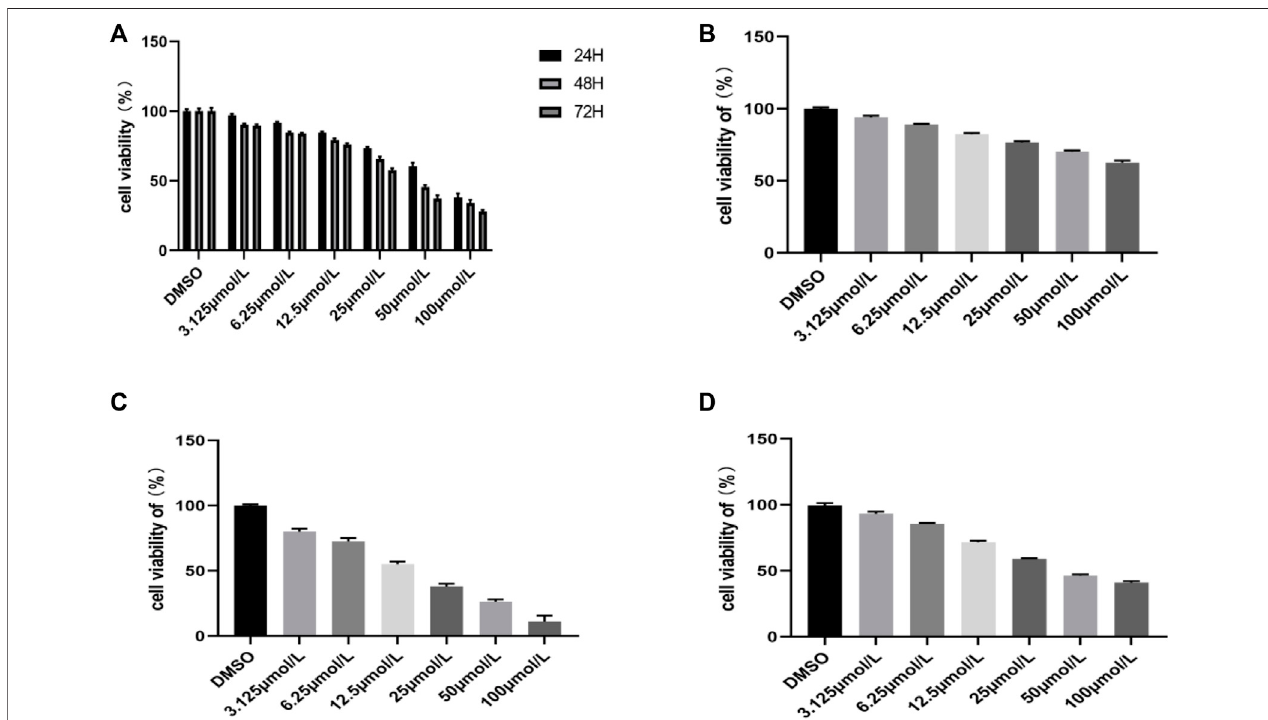
FIGURE 1 | Inhibitory effects of the compound RPDPD on HeLa cells. (A) Cell viability of HeLa cells treated with different concentrations of compound RPDPD for 24, 48, and 72 h. (B) Cell viability of normal hepatocyte LO2 cells treated with different concentrations of compound RPDPD for 48 h. (C) Cell viability of LO2 cells incubated with different concentrations of cisplatin for 48 h. (D) Cell viability of HeLa cells incubated with different concentrations of cisplatin for 48 h.